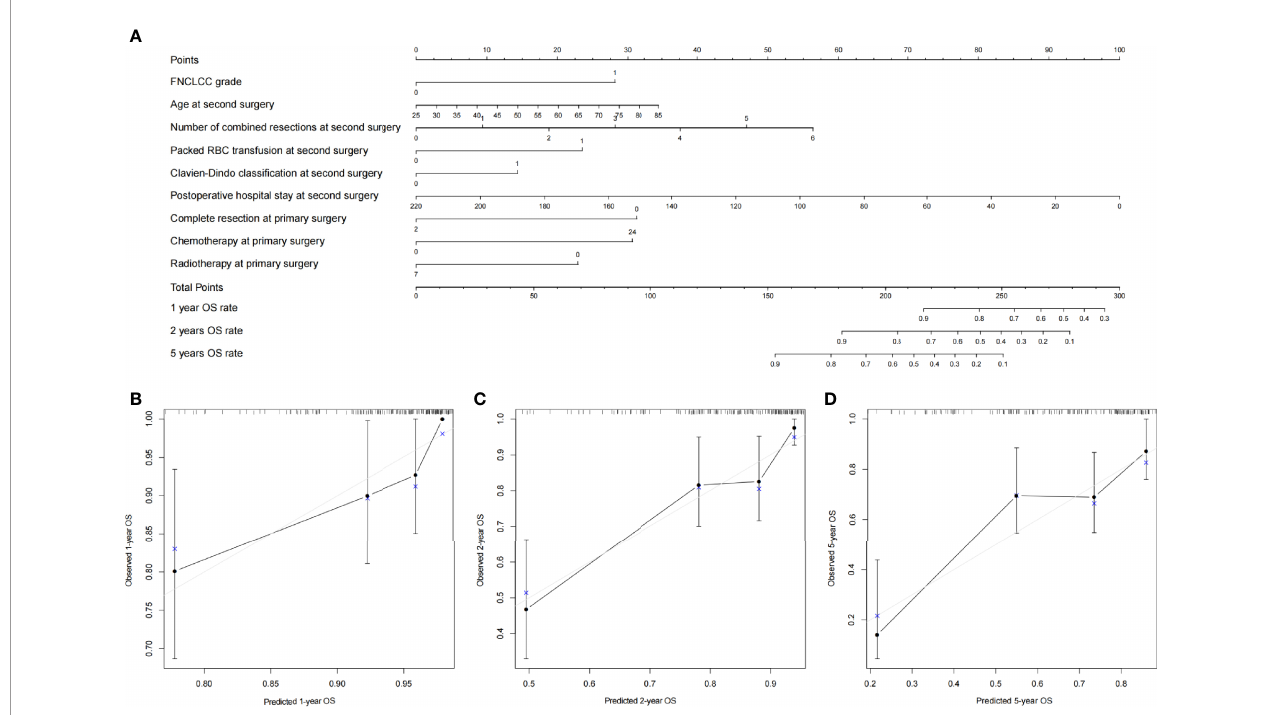
FIGURE 3 | (A) Nomogram for 1-, 2-, and 5-year overall survival in patients with fi rst local recurrent retroperitoneal sarcoma and calibration plots for internal validation of (B) 1-, (C) 2-, and (D) 5-year overall survival nomogram.